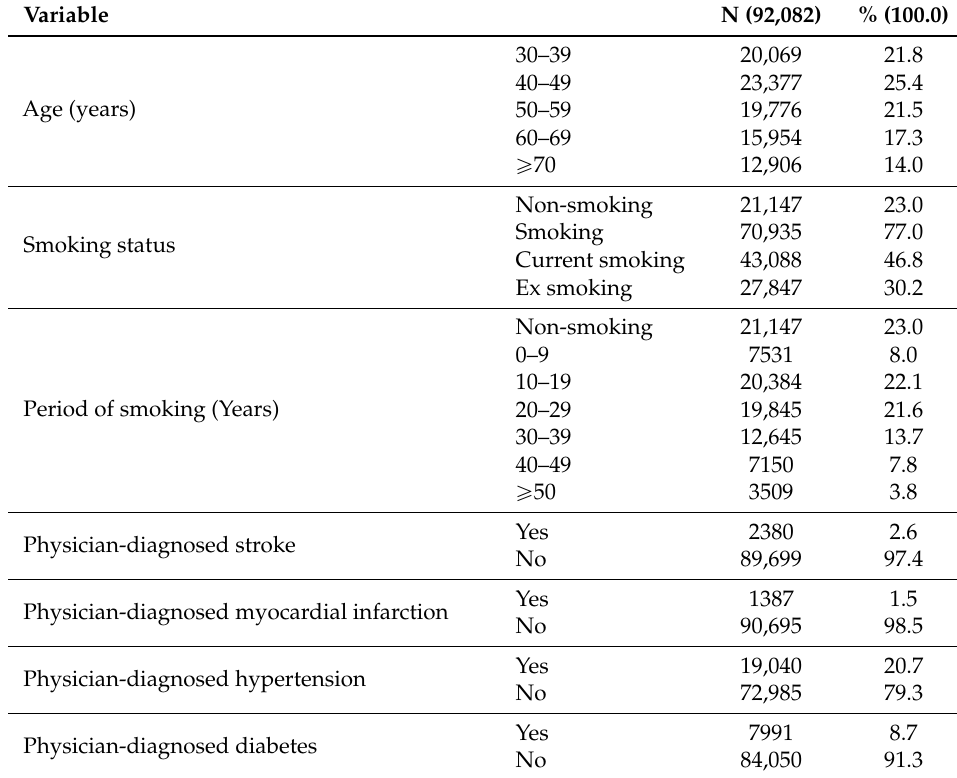
Table 1. General characteristics of the study